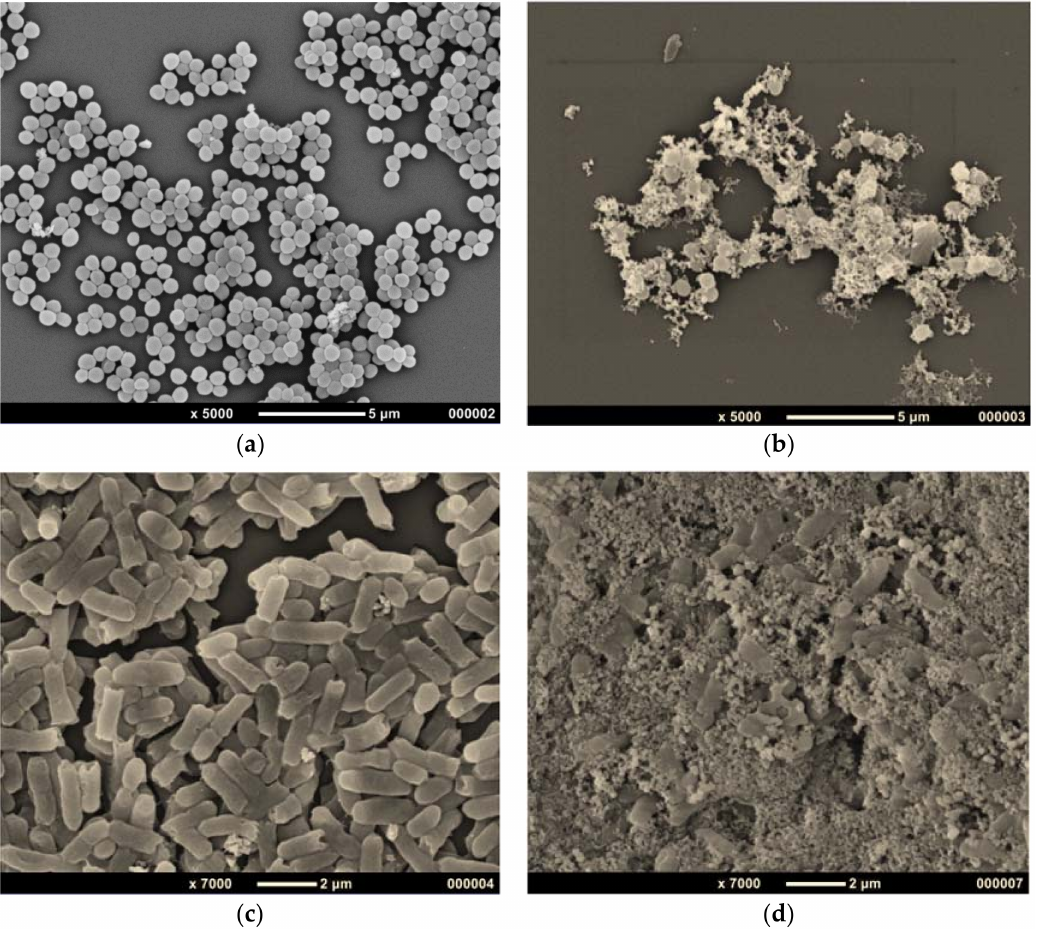
Figure 2. Scanning electron microscopy images of ( a ) S. aureus control; ( b ) S. aureus with treatment from green plum flesh water extract; ( c ) E. coli control and ( d ) E. coli with treatment from green plum flesh water